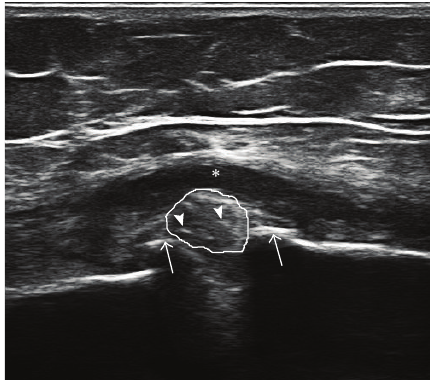
Figure 3: Medial meniscus of a subject with advanced osteoarthritis of the medial compartment of the knee. In this case we can observe parameniscal fluid collection (asterisk), osteophytes of both the femur and tibia, advanced meniscus degeneration with loss of the typical triangular shape of the meniscus (thin white line), and marked inhomogeneity of the US structure. In the meniscus we can observe thin linear hyperechogenic deposits (arrowheads) that could be due to CPPD deposits. In this case only a part of the medial meniscus could be adequately visualized, with the risk of missing other, more characteristic, deposits that could facilitate diagnosis. CPPD crystals were present in this meniscus, but we were not able to define whether these lines were due to CPPD crystals or